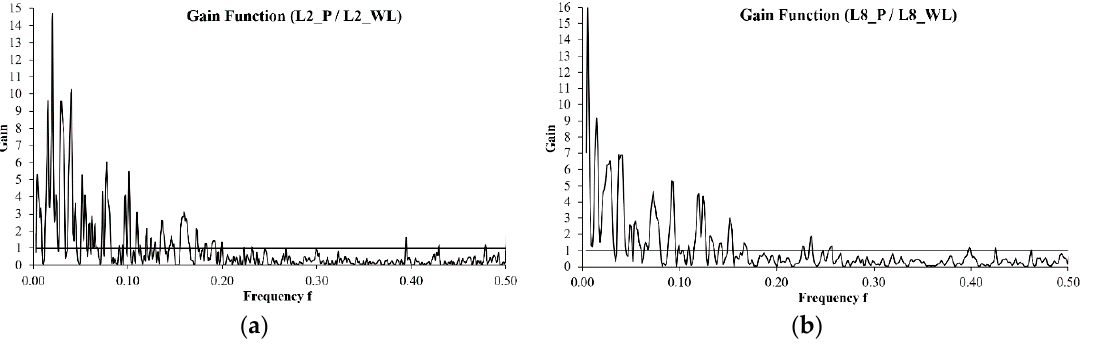
Figure 20. ( a ) The gain function between the L2_P and L2_WL data; ( b ) the gain function between the L8_P and L8_WL data.